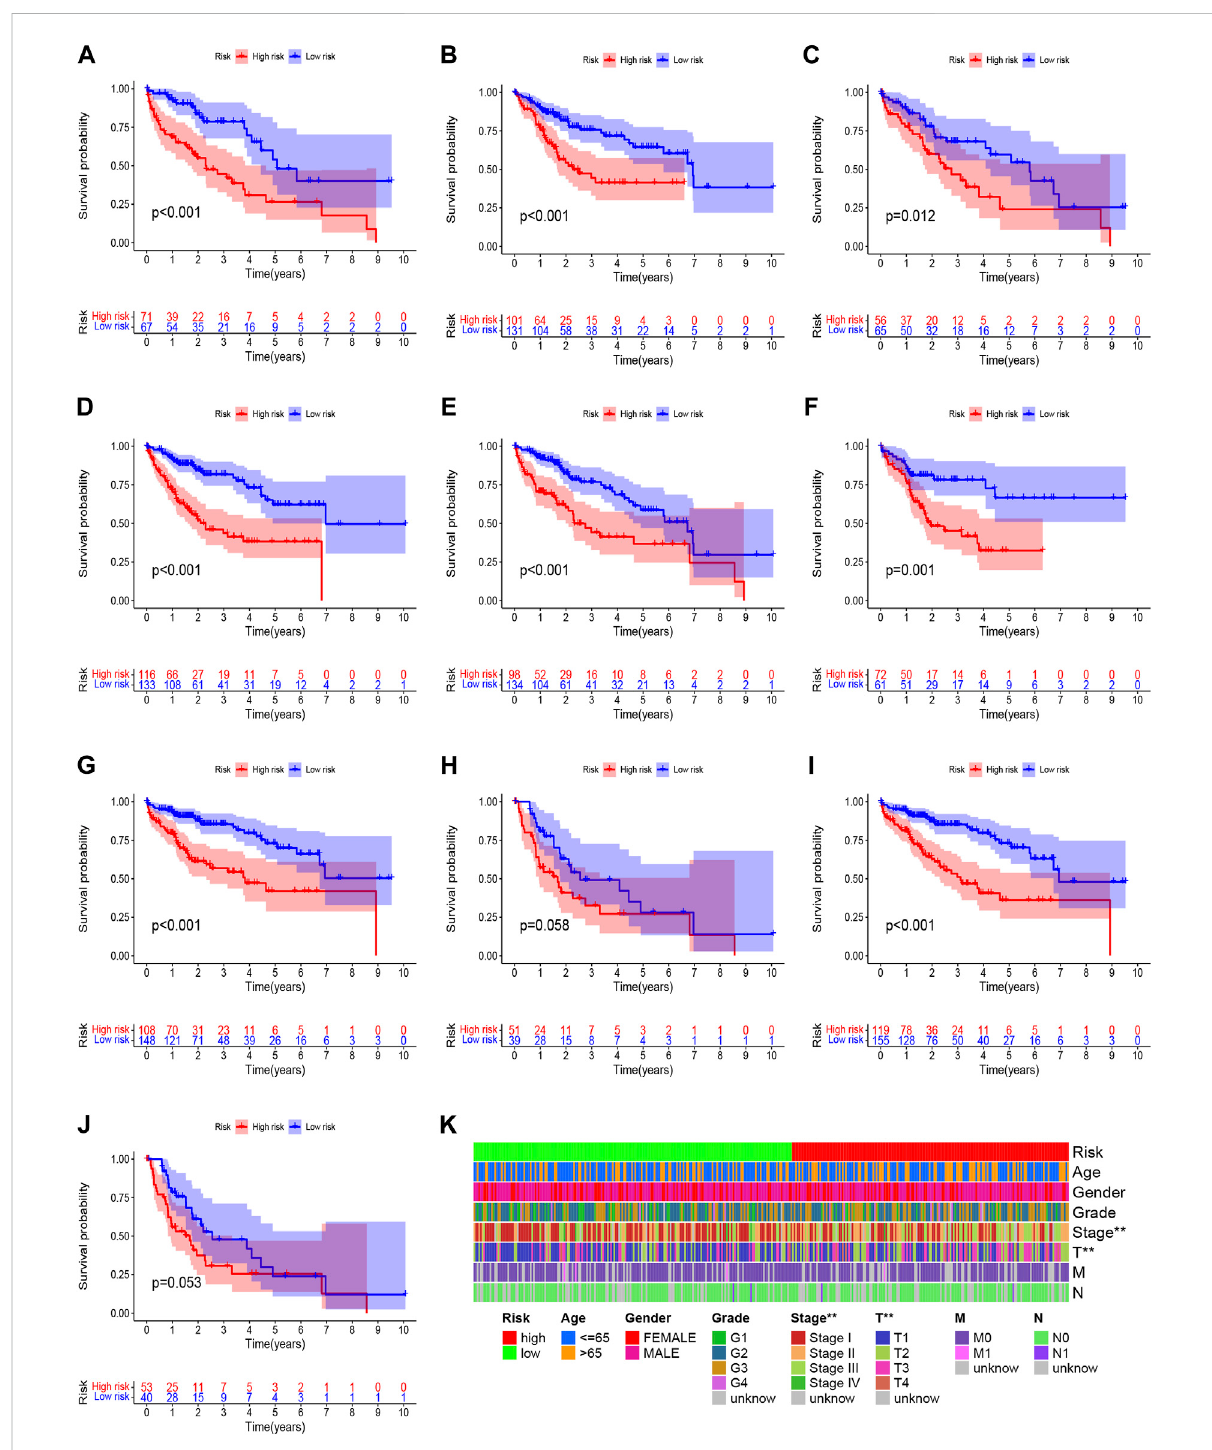
FIGURE 4 Clinicopathological features analysis in the high- and low-risk score group. (A) Patients with age > 65; (B) Patients with age ≤ 65; (C) Female patients; (D) Male patients; (E) Patients with Grade G1-2; (F) Patients with Grade G3-4; (G) Patients with stages I-II; (H) Patients with stages III-IV; (I) Patients with stages T1-2; (J) Patients with stages T3-4; (K) Heatmap of clinicopathological features in the high-risk and low-risk